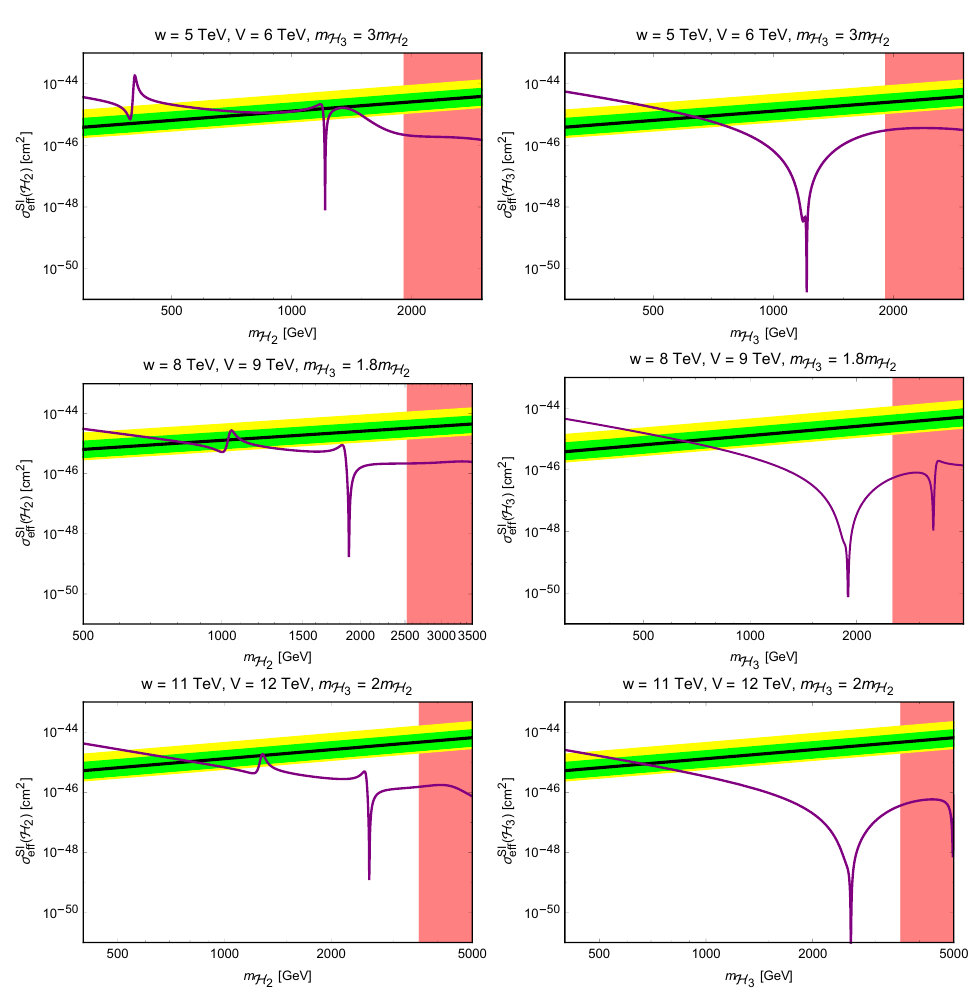
Figure 12 . The spin-independent dark matter-nucleon scattering cross-section limits as a function of dark matter masses according to each choice of w; V and m unstable regime is input as